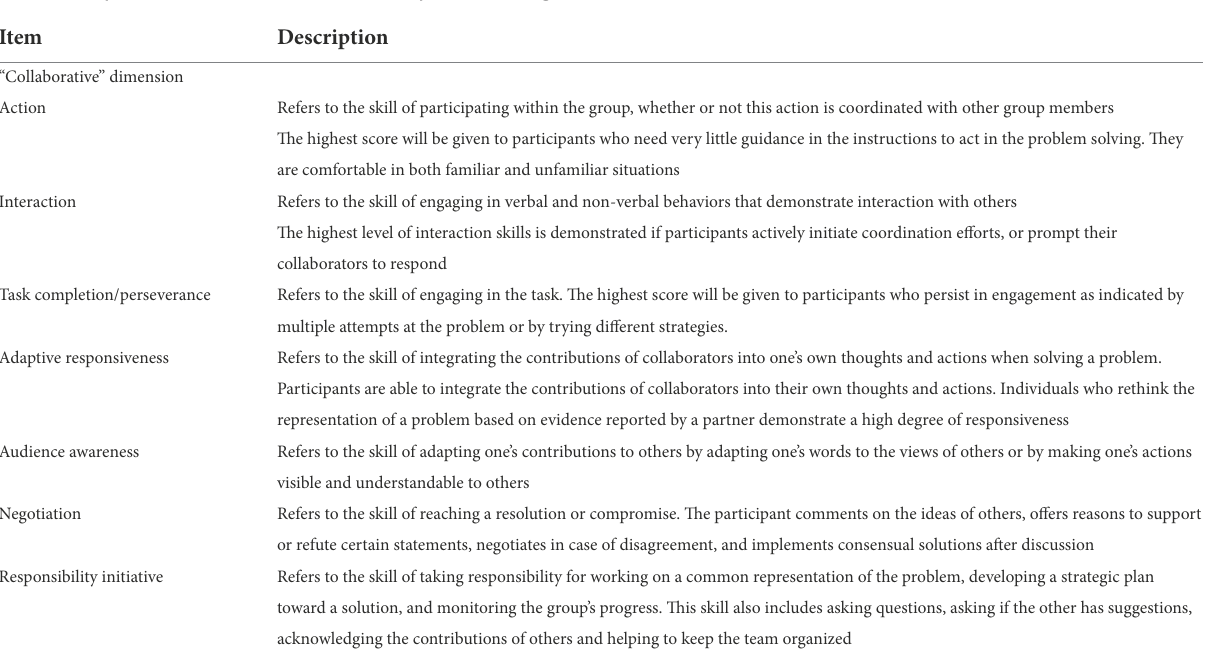
TABLE 3 Adaptation of Social skills in collaborative problem